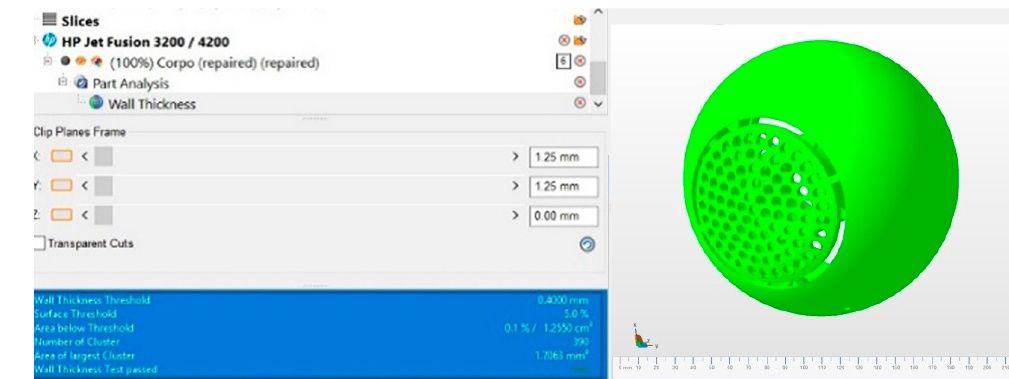
Figure 17. Wall thickness test.